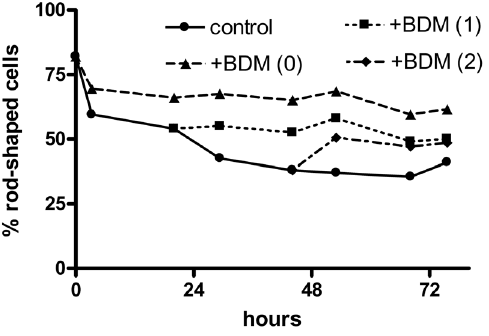
Figure 6. Effects of BDM addition after one or two days of hypothermic incubation. Cardiac myocytes were incubated at 3 u C for the time indicated on the x-axis, with additions of 5 mM 2,3- butanedione monoxime prior to the beginning of the incubation (triangles) or after one (squares) or two (diamonds) days; controls (circles) had no addition. The percentage of rod-shaped cells at each time point is shown. Results are means from two experiments.